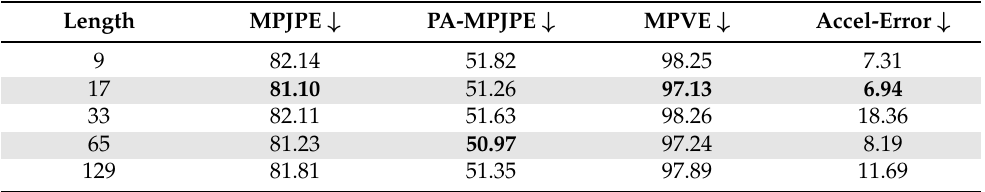
Table 1. Performance comparison of HPR-Net according to different pose chunk length. Bold values indicate best results.